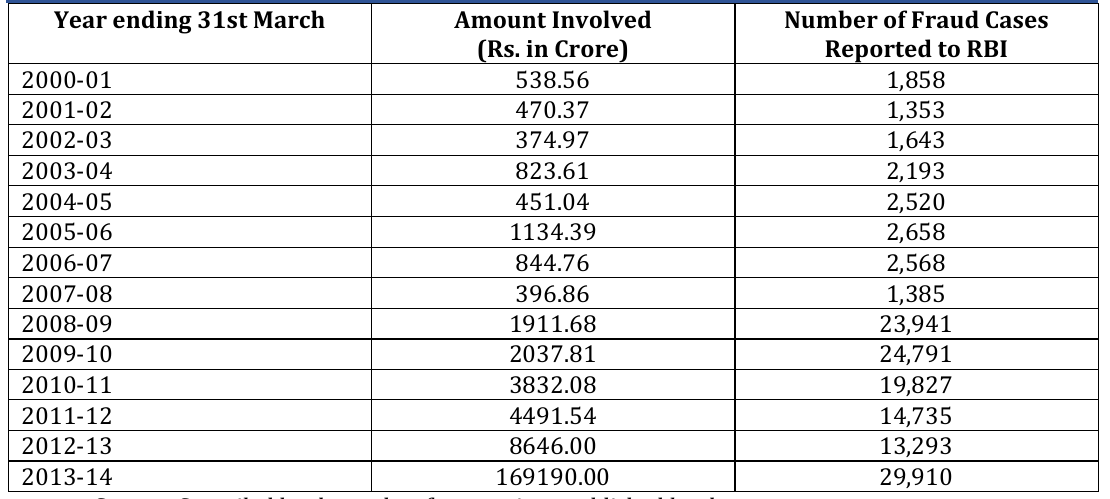
Table 2: Number of Frauds and Amount Involved in Indian Banks